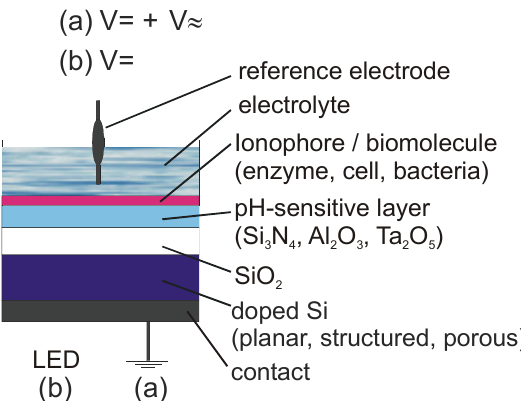
Figure 3. Capacitive field-effect structures realised in this work (schematically), based on EIS sensors (a) and LAPS principle